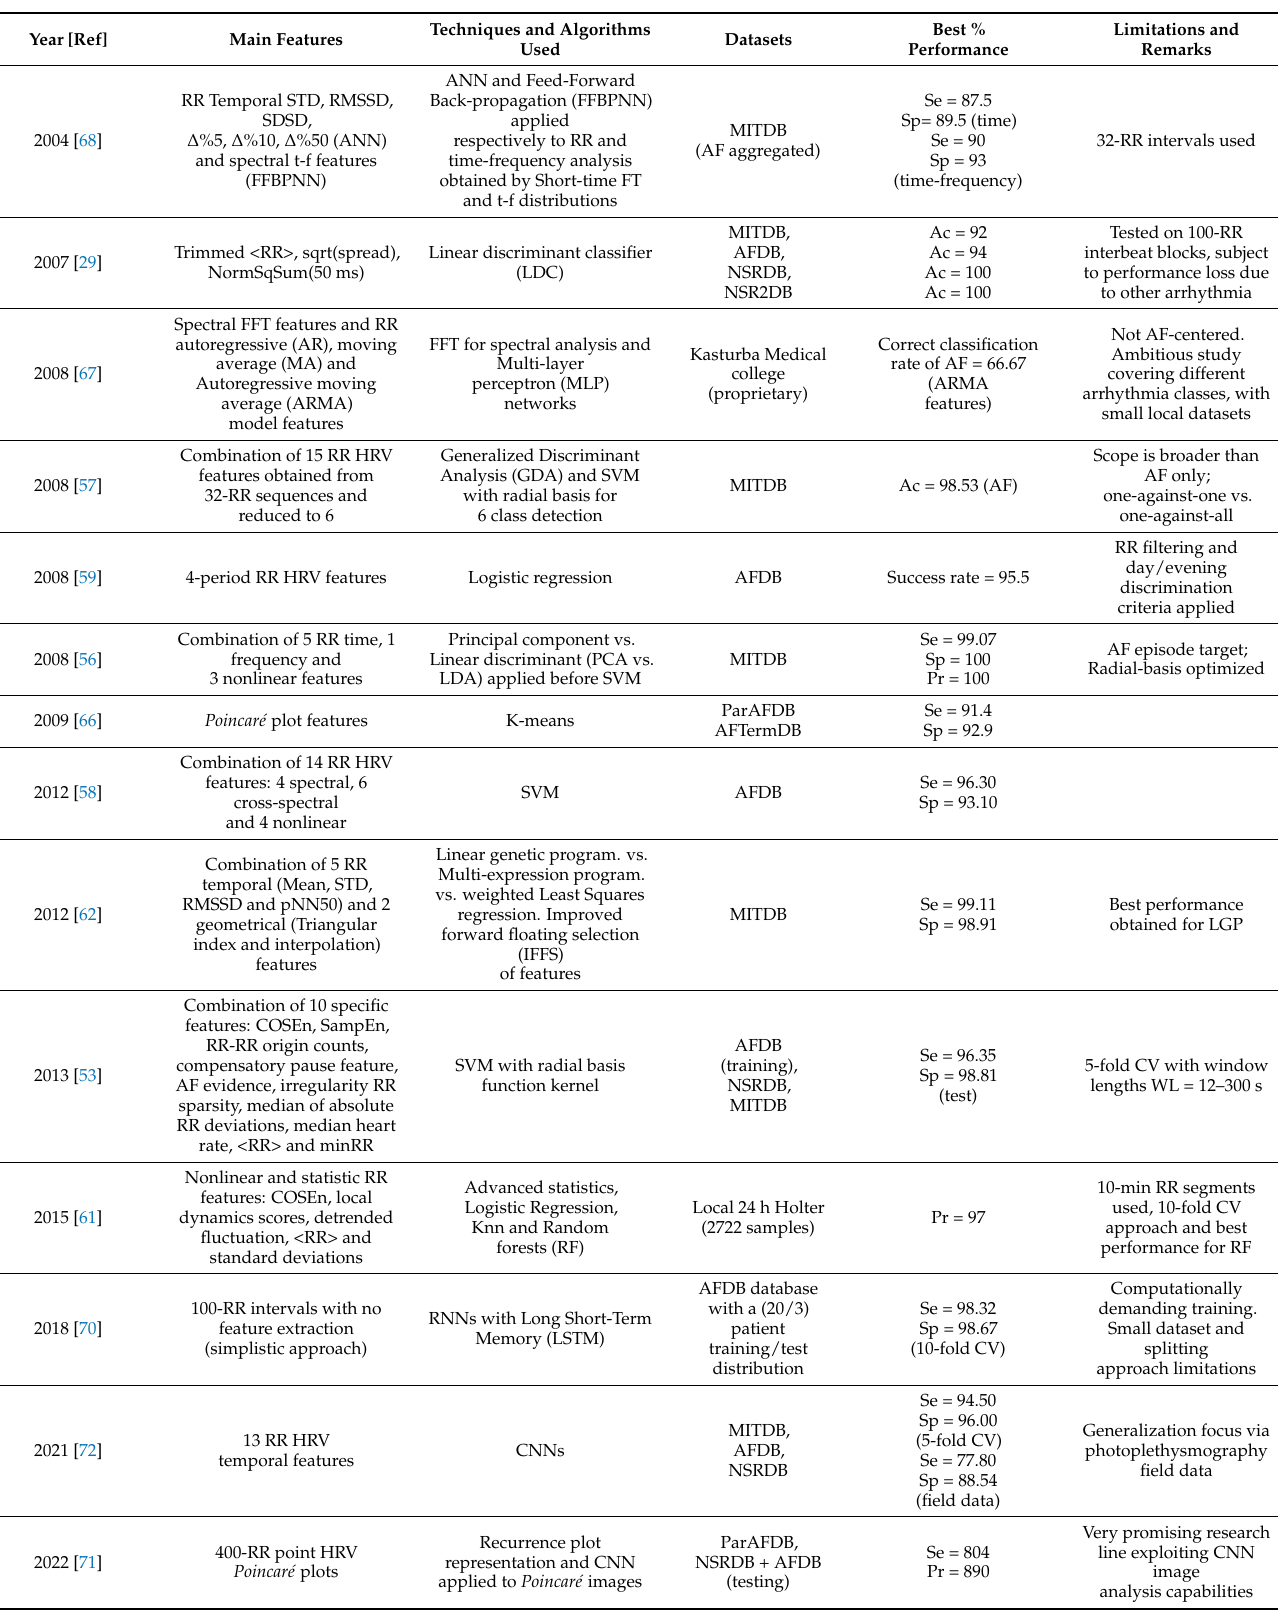
Table 3. Summary of chosen multivariate AF research studies published after year 2000, sorted